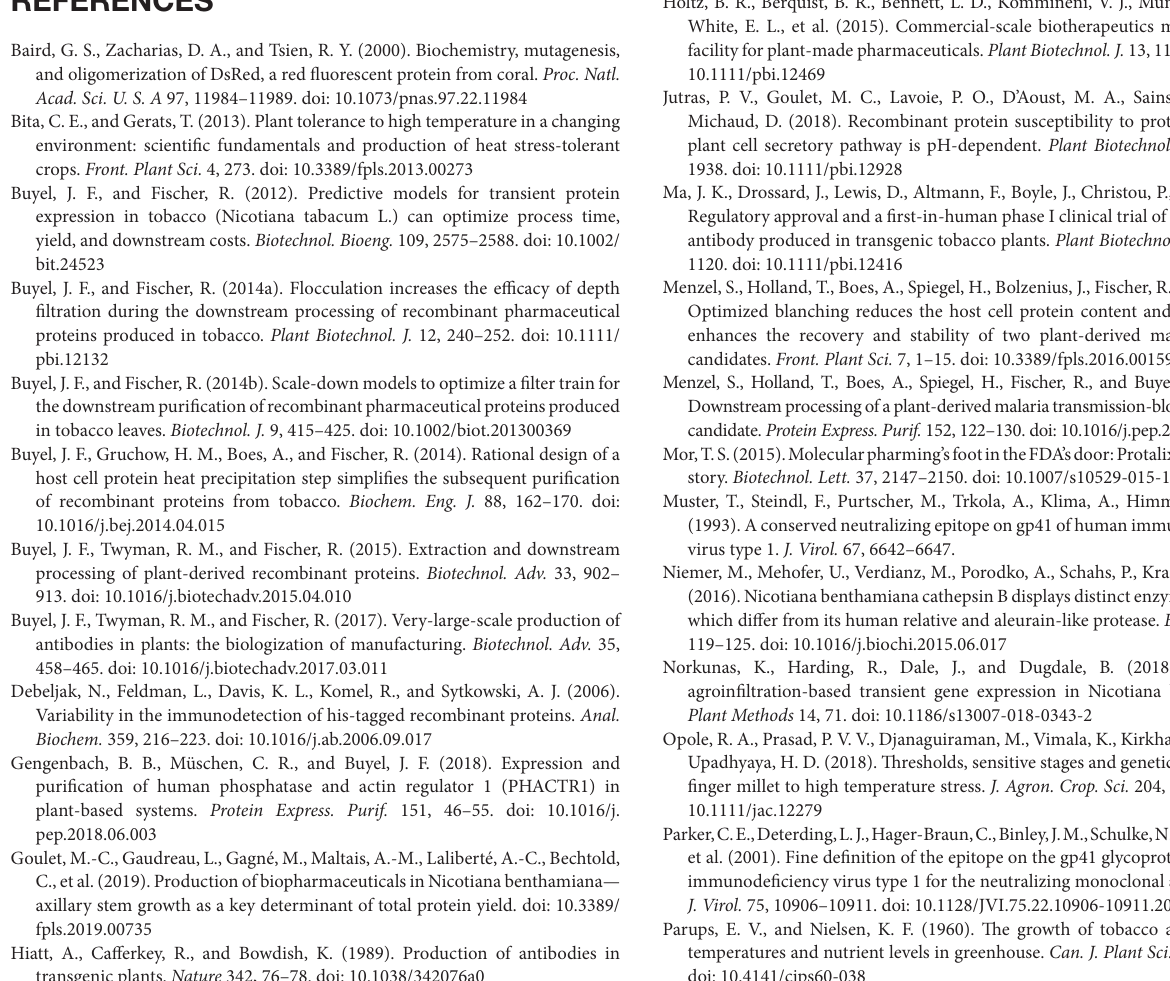
and product parameter results. The recovery is defined as the ratio of DFE in the elution fraction (after purification) and the DFE amount in the load (before purification). Horizontal lines indicate the average parameter value for that batch calculated based on all harvests of one batch, whereas colored point-scatter plots correspond to the individual harvest-specific values in the second batch set. Vertical colored dotted lines mark the transitions between the growth phases in each batch (left line = germination to sprouting, middle line = sprouting to growth, and right line = growth to maturation). FIGURE S3 | Correlations and cross-correlations between independent cultivation parameters observed for a second set of six batches (2.1–2.6). Three harvests spaced 1 week apart were conducted per batch resulting in a total of 18 data points (dots). Dots are colored according to the DFE yield after purification. Lines represent linear regression models for the parameters in the corresponding row and column and are colored according to their p -value: green = p < 0.01, orange = 0.01 < p < 0.05 and gray = p ≥ 0.05. Histograms in the diagonal of panels represent the distribution of the parameter defined by the corresponding row/column. FIGURE S4 | Correlation between selected independent cultivation parameters and dependent biochemical and product parameters observed for a second set of six batches (2.1–2.6). Three harvests spaced 1 week apart were conducted per batch resulting in a total of 18 data points (dots). Dots are colored according to the DFE yield after purification. Lines represent linear regression models for the